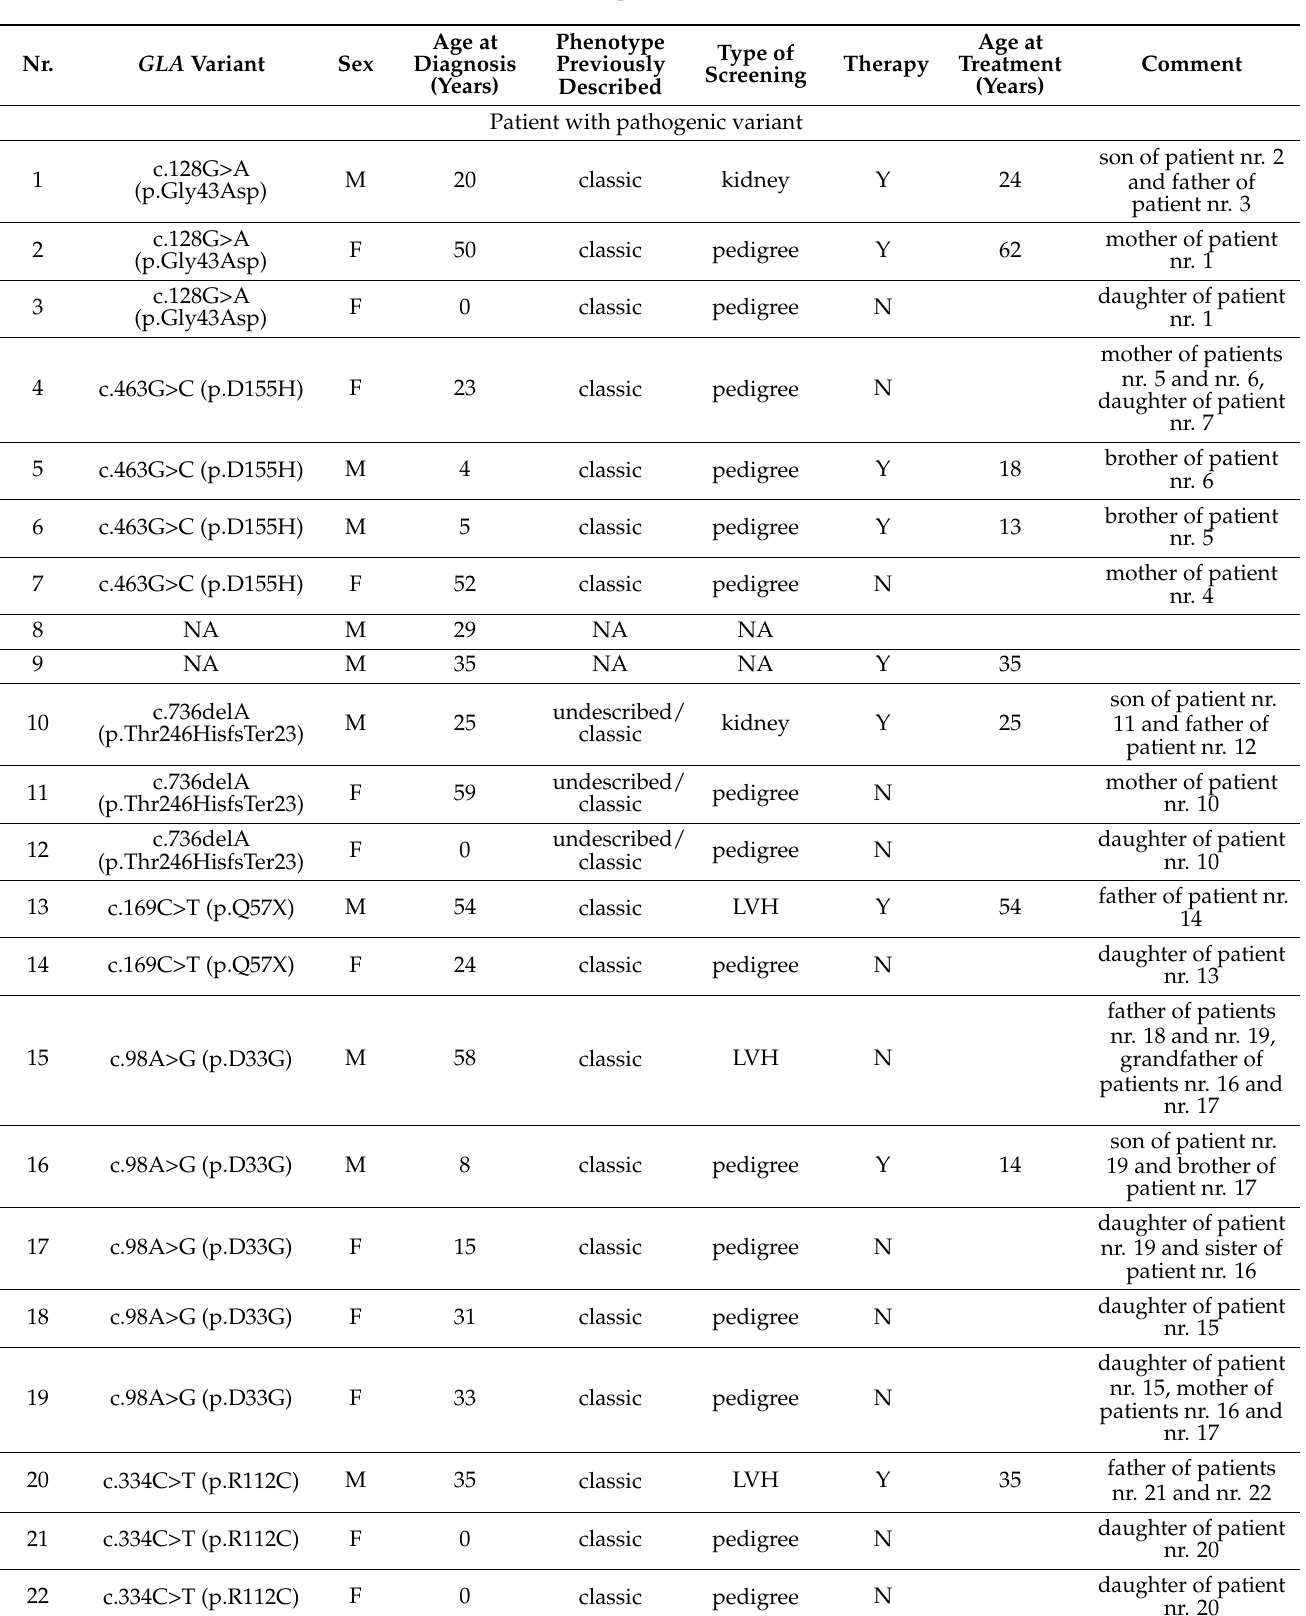
Table 1. Data of 48 Slovak FD